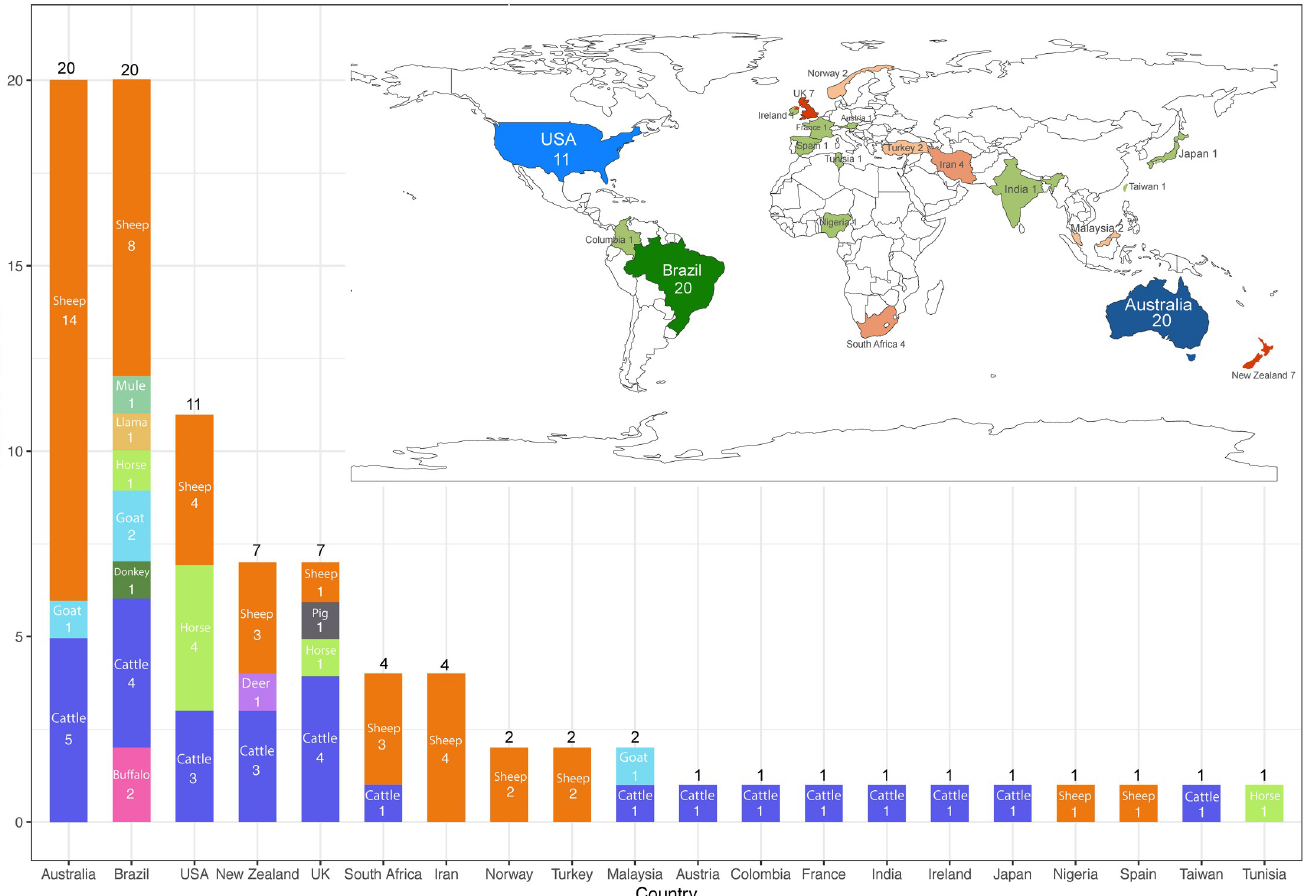
Fig 2. Global geographic distribution and species differentiation of peer-reviewed case reports of clinical photosensitisation in domestic livestock.